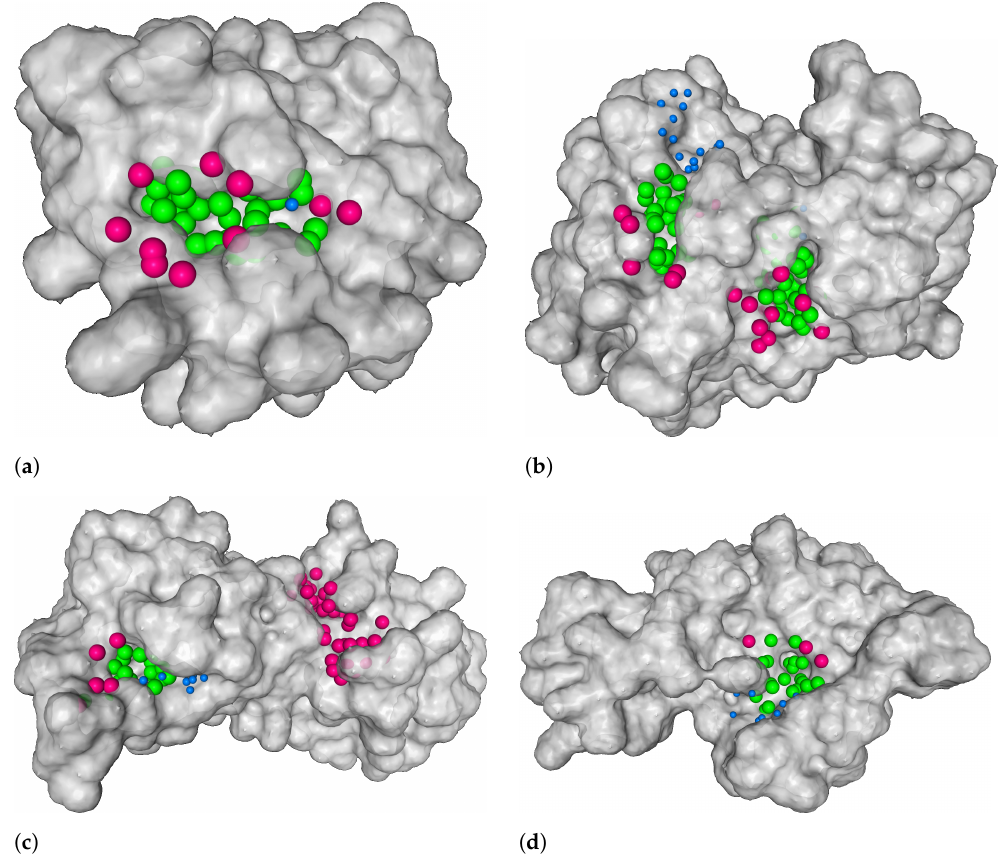
Figure 8. Four examples of our model’s output. The green balls on the protein surface represent points that were correctly predicted as ligandable points (true positives), blue balls represent points that were falsely predicted as non-ligandable points (false negatives), and pink balls represent points that were falsely predicted as ligandable (false positives). True negatives are not shown. In all figures, there are binding sites that were correctly predicted by our model. ( b ) Example where the location of a binding site was not detected—this is depicted with blue balls. ( c ) Example of a predicted binding site that is not present in our dataset—it is depicted with pink balls. ( a ) 4rrg, chain C [41,42]. ( b ) 3lw0, chain D [43,44]. ( c ) 3nk7, chain B [39,40]. ( d ) 1tkg, chain A